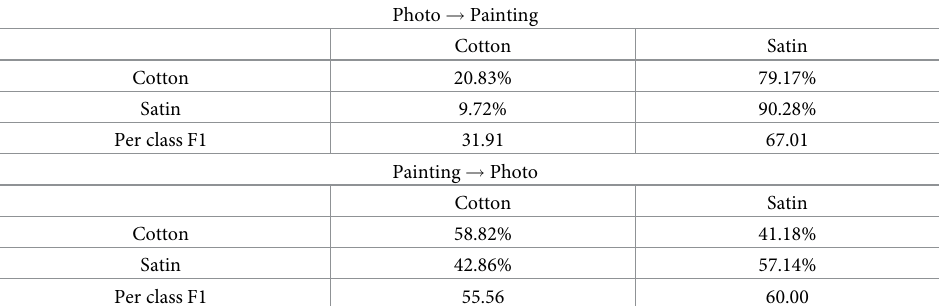
Table 5. Confusion matrix for the two classifiers. The top represents the classifier trained on photos, tested on paint- ings which is heavily biased towards satin. The bottom represents the classifier trained on paintings, tested on photos, which is more balanced in its predictions.